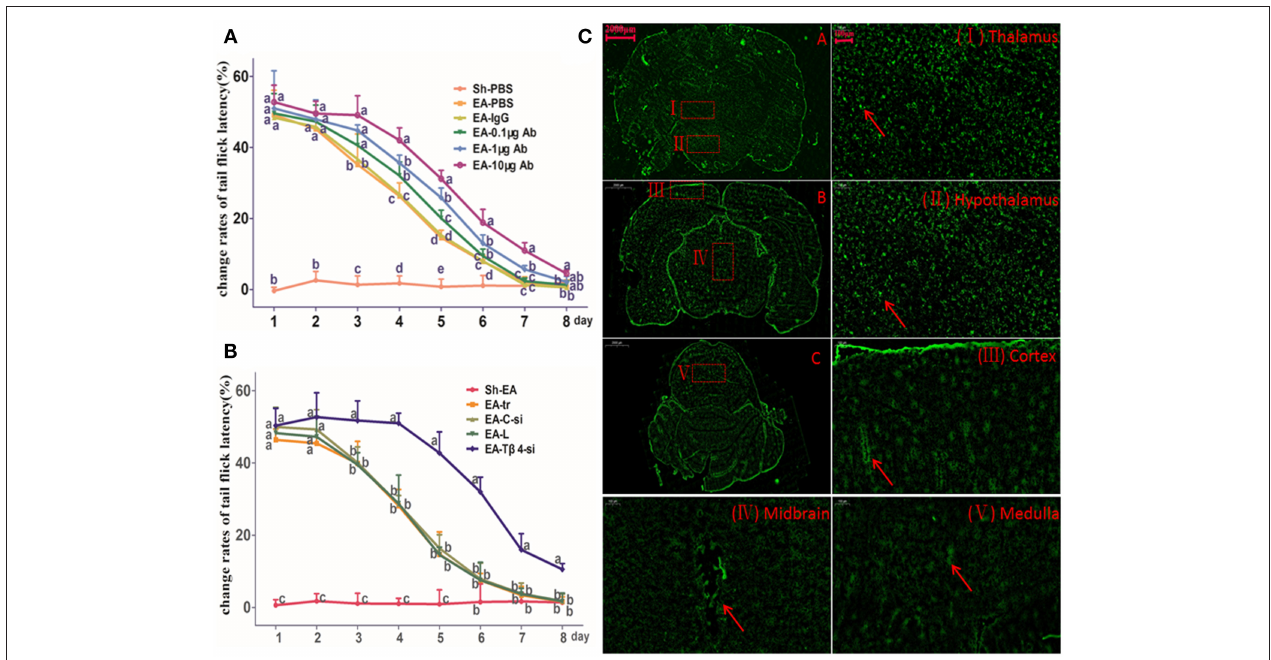
FIGURE 3 | The effect of intracerebroventricularly (icv) injection of T β 4 antibody or siRNA on electroacupuncture (EA)-induced tail flick latency (TFL). (A) The effect of icv injection of T β 4 antibody on change rates of TFL (mean ± SD, %, n = 6). The values with different letters differ significantly in different groups at the same day ( P < 0.05). One-way ANOVA followed by Bonferroni’s post-test. (B) The effect of icv injection of T β 4 siRNA on change rates of TFL (mean ± SD, %, n = 6). The values with different letters differ significantly in different groups at the same day ( P < 0.05). One-way ANOVA followed by Bonferroni’s post-test. (C) The fluorescence in cortex, thalamus, hypothalamus, mid-brain and medulla. Arrows point to the high fluorescence intensity. Scale bars represent 2,000 µ m in picture (A–C) , and 100 µ m in